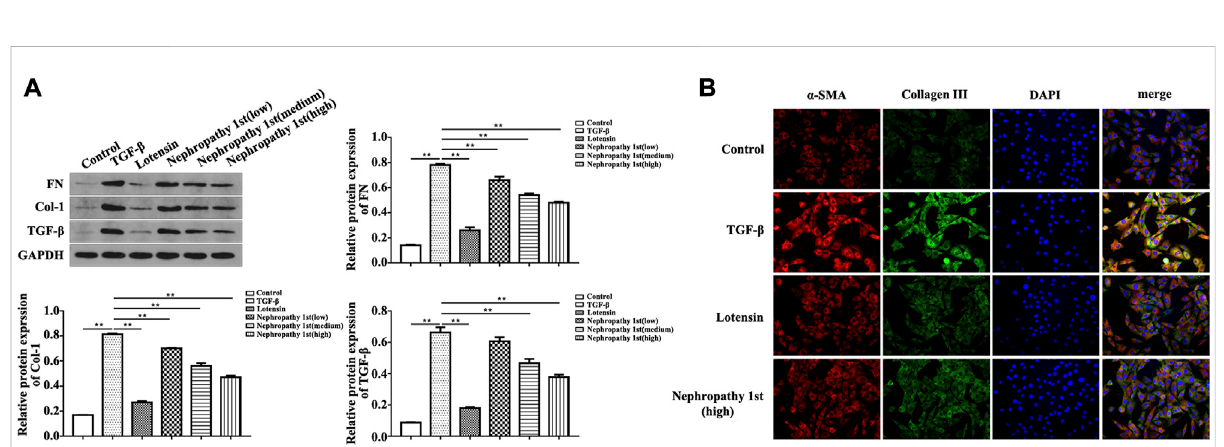
FIGURE 3 Nephropathy 1st inhibited the pro- fi brotic phenotypes in NRK-49F cells. Western blot was used to detect the expression of the biomarkers of renal fi brosis, including FN, col-1, and quanti fi cation of the expression of FN and col-1. changed to: Nephropathy 1st inhibited the pro- fi brotic phenotypes in NRK-49F cells. (A) Western blot was used to detect the expression of the biomarkers of renal fi brosis, including FN, col-1, and quanti fi cation oftheexpressionof FNandcol-1. (B) Immuno fl uorescence staining wasused todetect theexpressionof α -SMAand collagenIII. Data were representative of three independent experiments. * p < 0.05 and ** p <